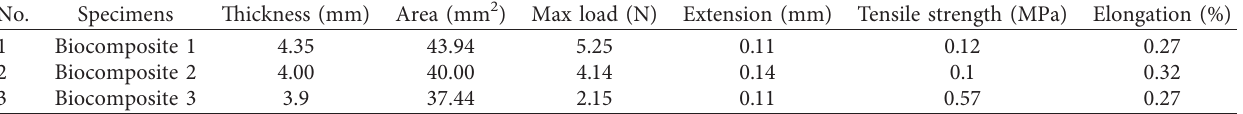
Table 6: Biocomposite tensile strength